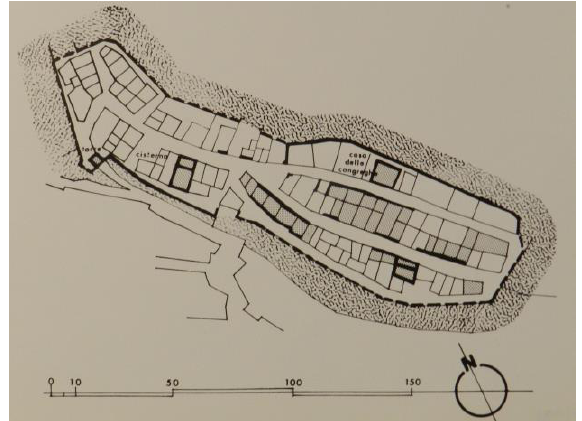
Figure 3. Planimetric layout of the hamlet in 1780 (after Viglino Davico, 1978).